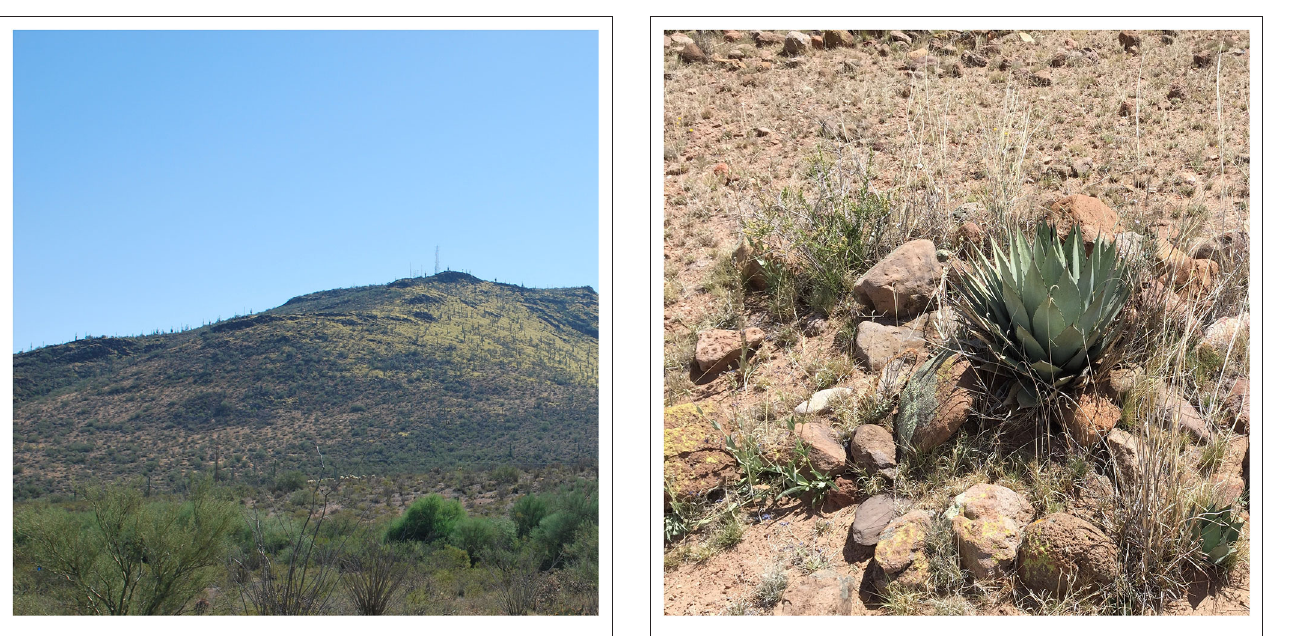
FIGURE 2 | Archaeological site at Tumamoc Hill reserve in Tucson, Arizona. FIGURE 3 | Agave growing in ancient rock pile at archaeological site in Casas Grandes, Chihuahua, Mexico (picture courtesy of M. Searcy,